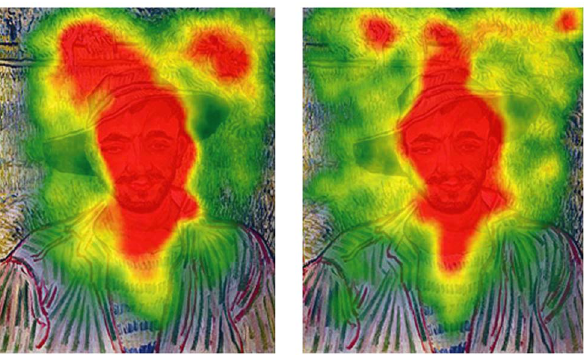
Fig. 5. Speaking effects on fixation dispersion and duration – van Gogh. Left side: Heat map visualising the total time certain areas of the painting have been fixated by the experimental group during minute 11 to 15. Areas fixated for more than 2,000 ms/minute are displayed in red. Colour scaling is in 200 ms steps. Right side: Heat map visualising the total time certain areas of the painting have been fixated by the control group during minute 11 to 15. Areas fixated for more than 2,000 ms/minute are displayed in red. Colour scaling is in 200 ms steps.